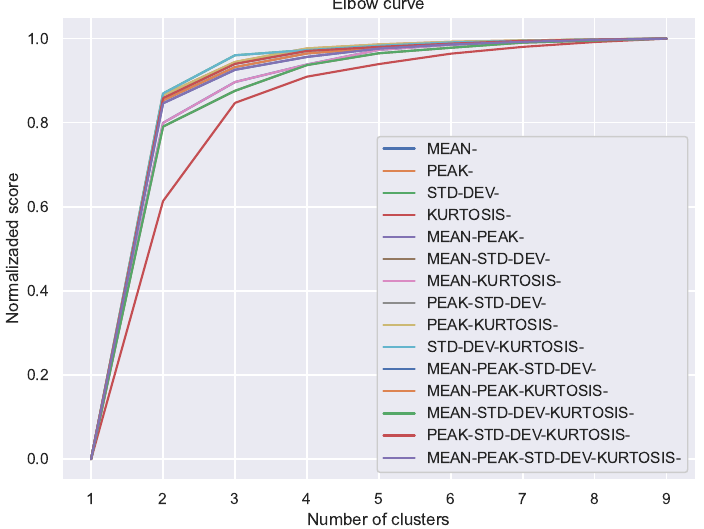
Figure 11. Curvas de codo para clasificaciones con las combinaciones de indicadores